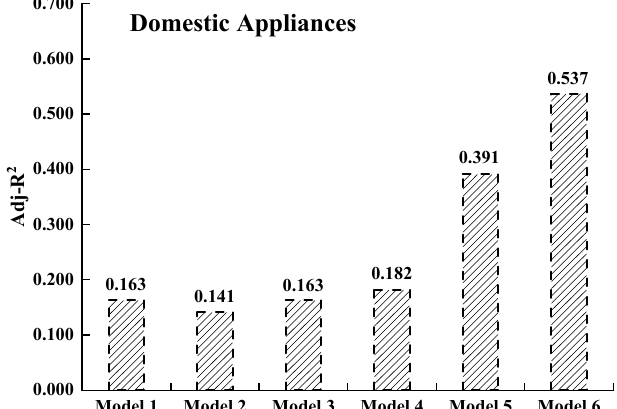
Figure 8. The Adj-R 2 of six domestic appliances energy consumption models.